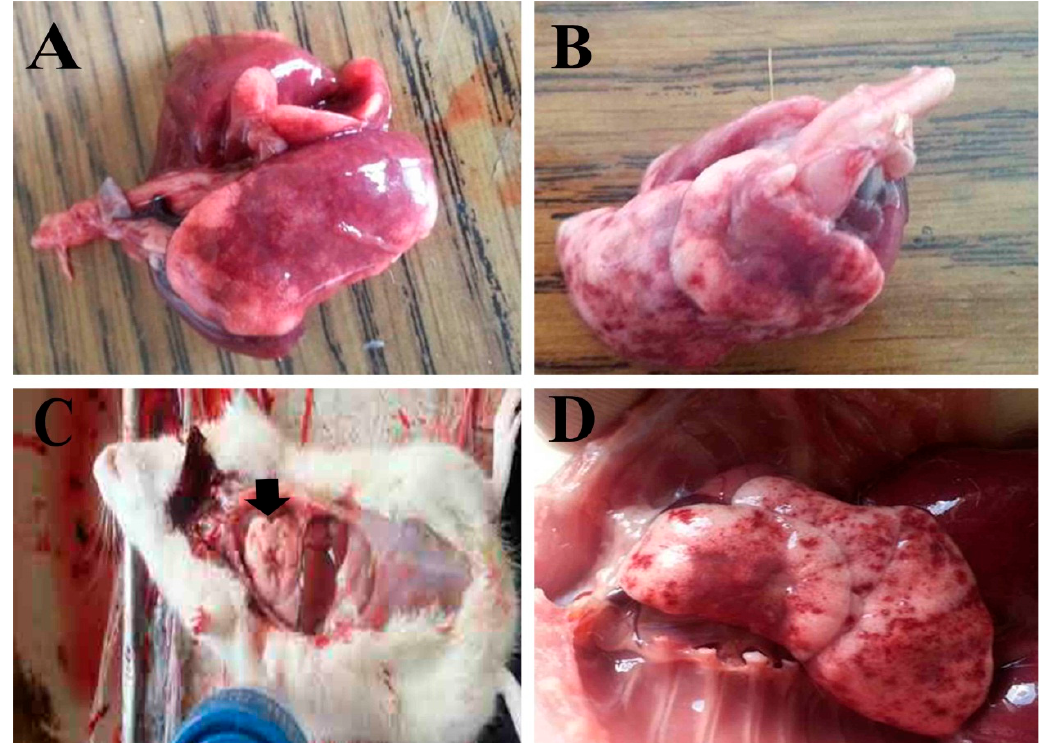
Figure 3. The effects of intratracheal administrations of bleomycin ( A , B ) or bleomycin + TQ-PLGA-PVA-NPs ( C , D ) on lung tissues of treated rats; ( A , B ) gross pneumonia (cornification and consolidation stage), depressed area, and compensatory emphysema in the periphery. ( C , D ) Similar gross lesions with less severity and incidence.